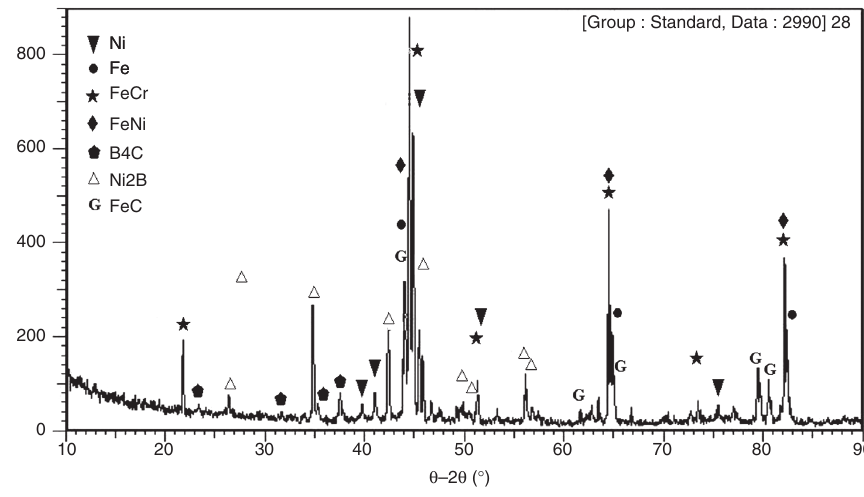
Figure 2 XRD spectrogram AstaloyCr-M-B